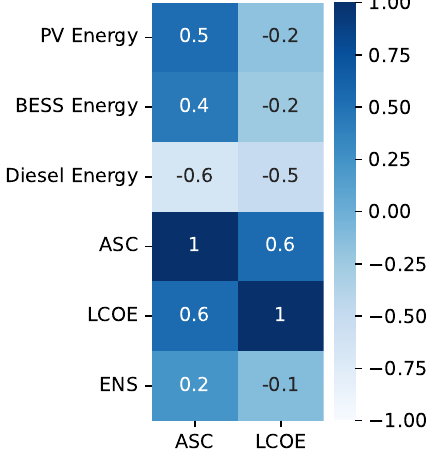
Figure 9. Energy correlating with ASC and